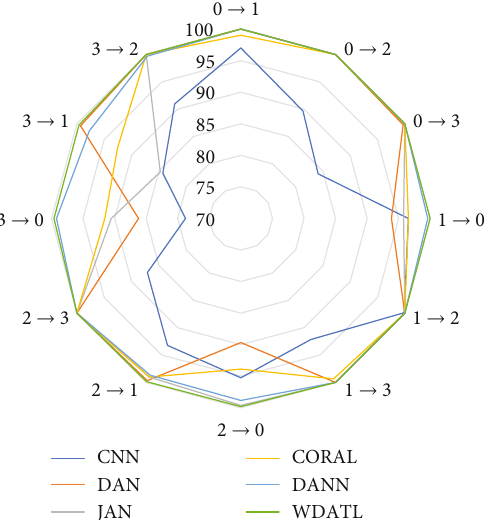
Figure 7: Radar diagram of diagnosis accuracy for di ff erent algorithms.